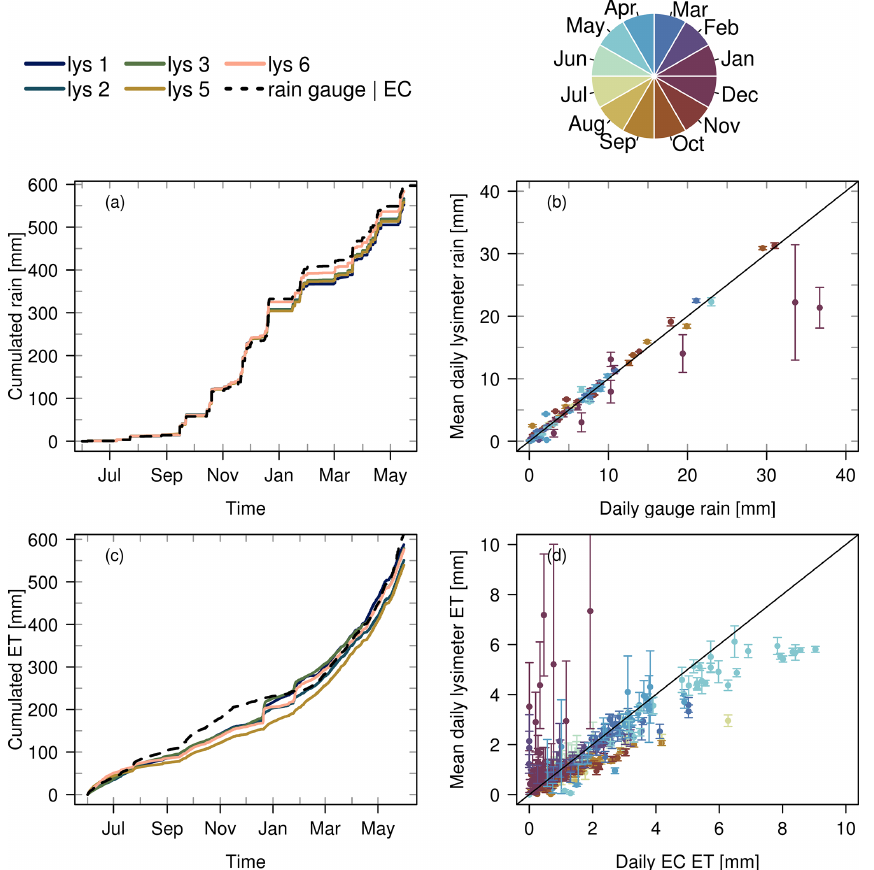
Figure 4. Comparison between cumulative (a, c) and mean diel (b, d) observations of rain and ET between the lysimeter and rain gauge (a, b) and lysimeter and EC (c, d) . The points and vertical error bars indicate mean and standard deviation between lysimeter columns, which include measurement uncertainty and spatial variability.